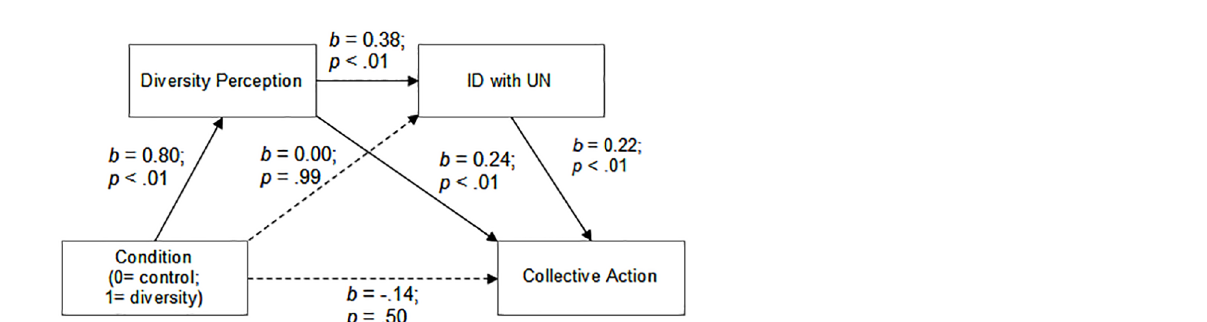
Figure 2. Mediation model with unstandardized values. Analysis of the hypothesized indirect effect of the training on collective action via diversity perception and identification with the United Nations. Coefficients of dotted paths are